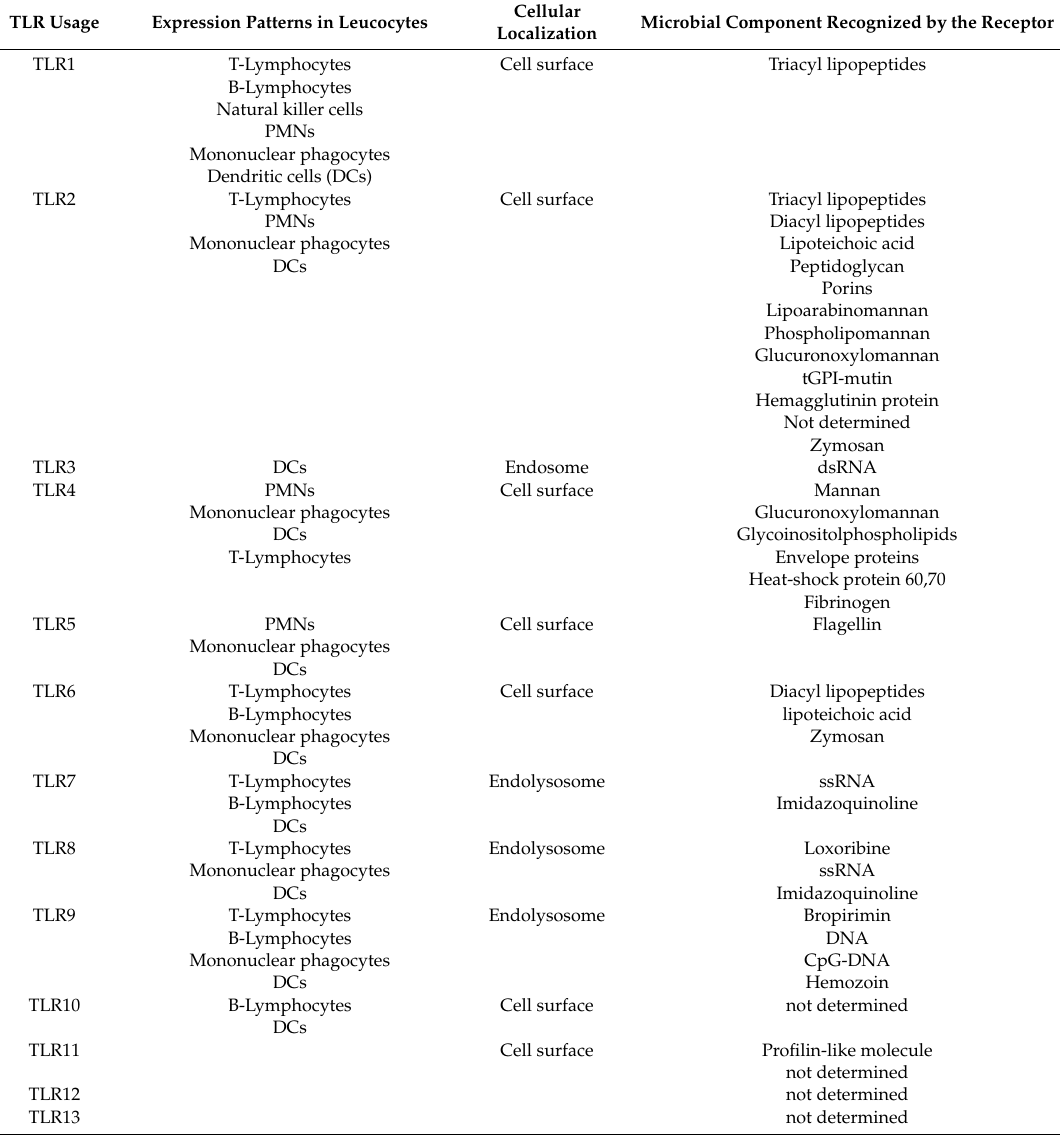
Table 1. TLR Recognition of Microbial Components